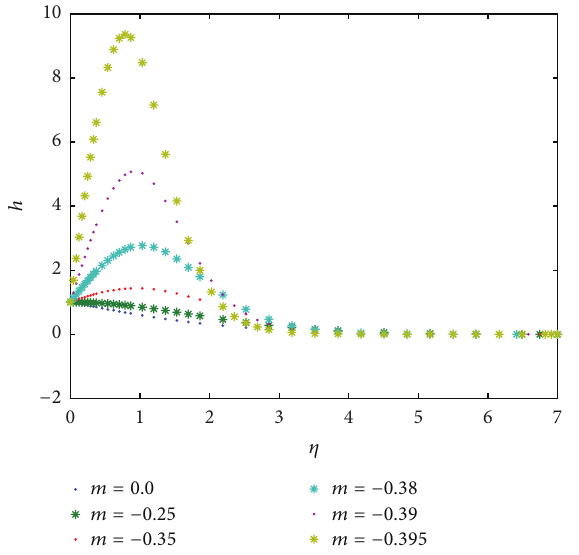
Figure 3: Approximate solution of the value 𝑓 󸀠 against 𝜂 for selected values of 𝑚